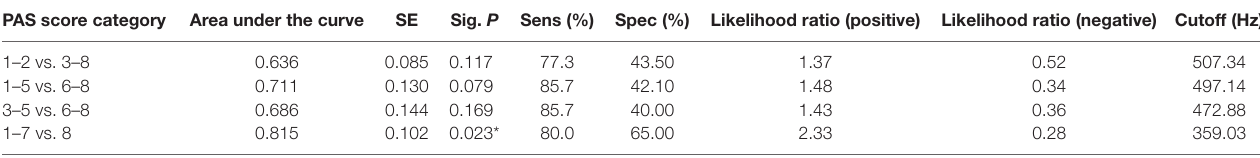
TaBle 3 | Results from receiver operating characteristics curve (ROC) analyses for maximum fundamental frequency for small bolus (5–10 mL thin liquids) Penetration/ Aspiration Scale (PAS) score category ( n = 45). Pas score category area under the curve